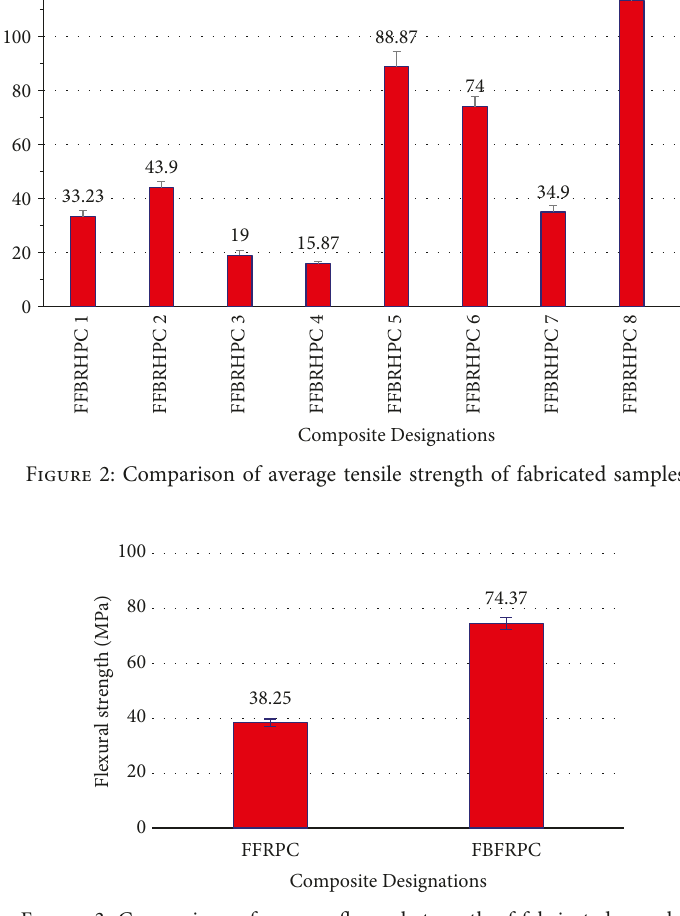
Figure 3: Comparison of average flexural strength of fabricated samples.